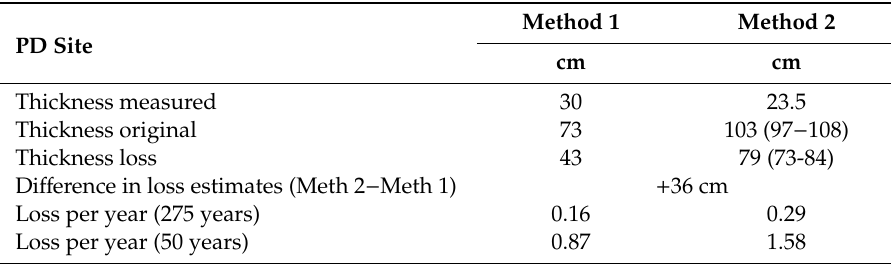
Table 4. Losses of thickness at PD.